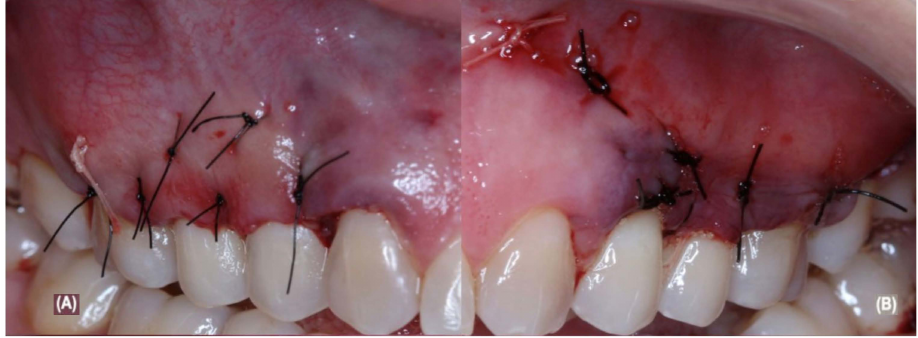
Figure 3. ( A ) show right flap sutured; ( B ) show left flap